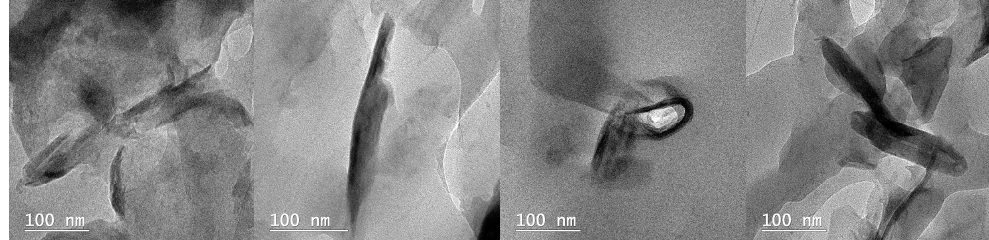
Figure 12. TEM images for HNT in PMMA materials obtained by favouring the interaction of EBS in the alpha form.